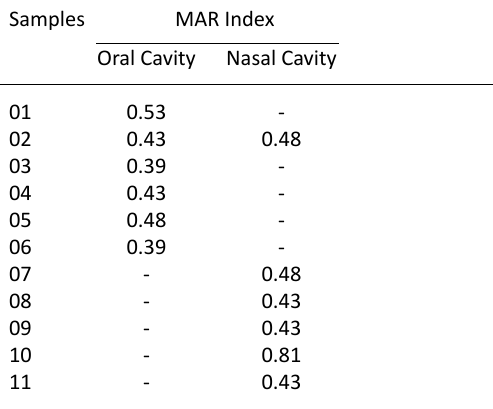
Table 3. The MAR index of the isolates belonging to the Enterobacteriaceae family from swabs of the nasal and oral cavity of horses used for animal traction in the municipality of Umuarama, Parana, Brazil, 2016 Samples MAR Index